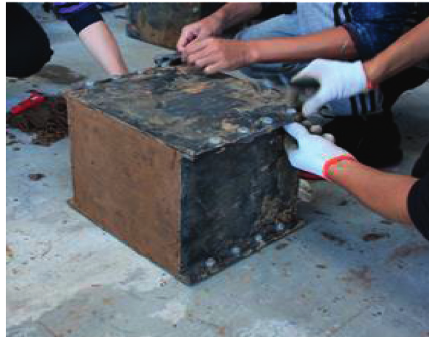
Figure 9: Removing the side plate of the soil collector.